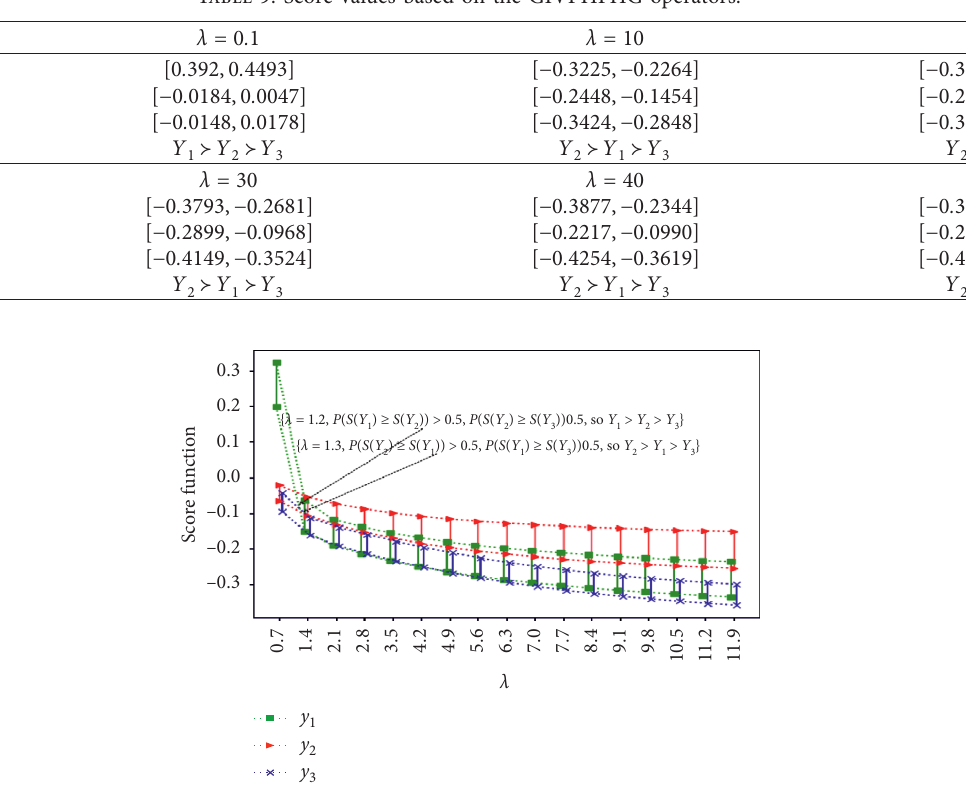
Figure 2: Variation of the score functions of the GIVPHFHG operators by the parameter λ